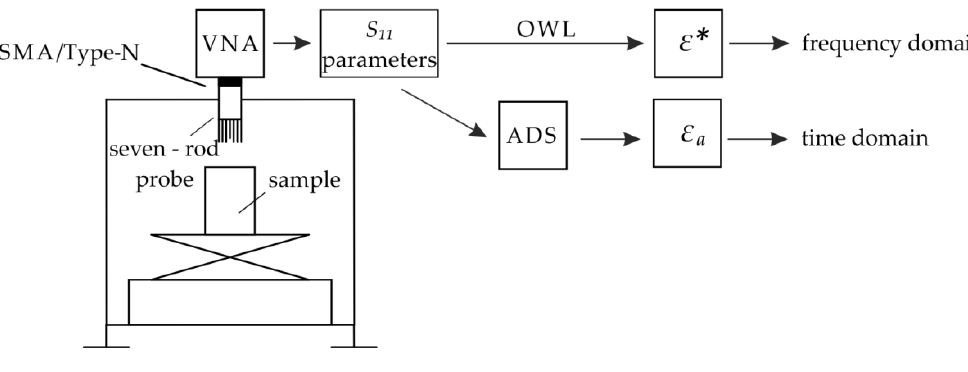
Figure 3. Overview of results processing.